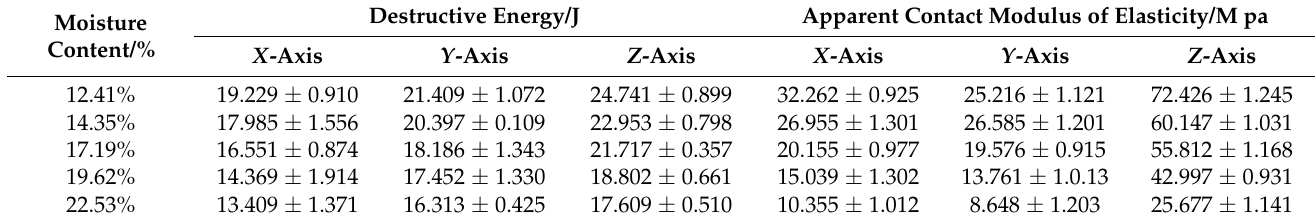
Table 2. Triaxial compression damage the energy and elastic modulus of sorghum seeds.